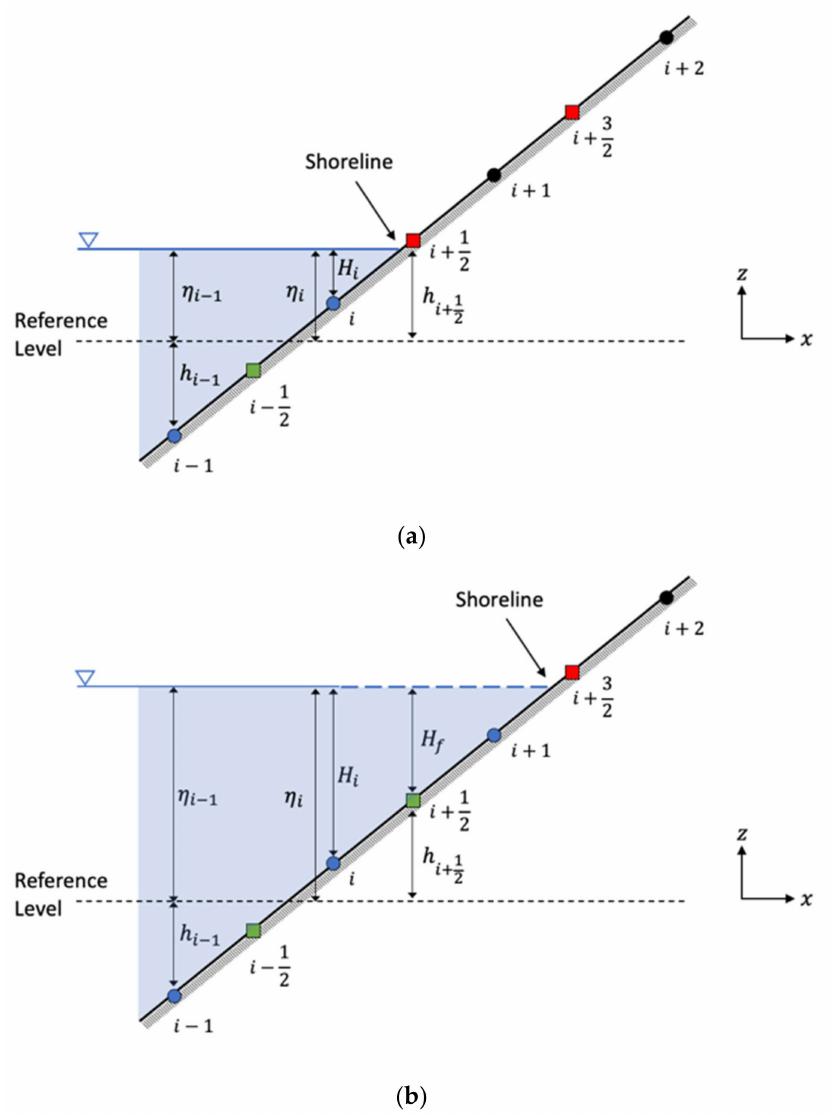
Figure 3. One-dimensional illustration for the moving boundary scheme: ( a ) the shoreline stops between the grid cells i and i+1; ( b ) the shoreline stops between the grid cells i+1 and i+2. Circles indicate the cell centers (blue–wet cells; black–dry cells); rectangles imply the cell edges for volume- flux components (green–nonzero flux; red–zero flux); the blue-shaded object identifies the water